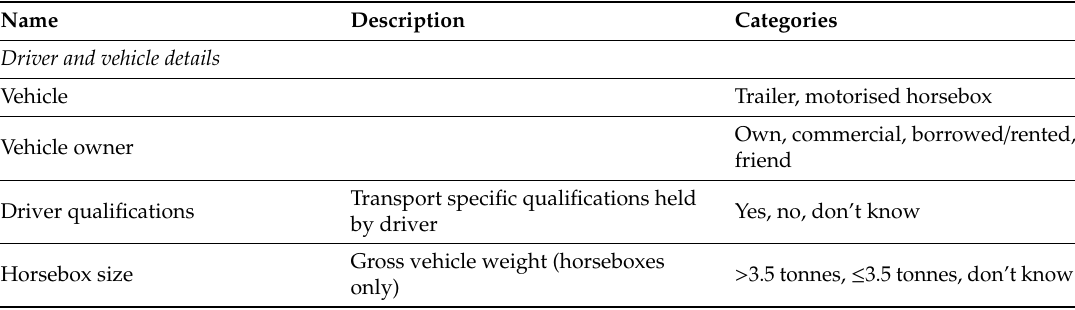
Table 2. Incident variables and outcomes including response